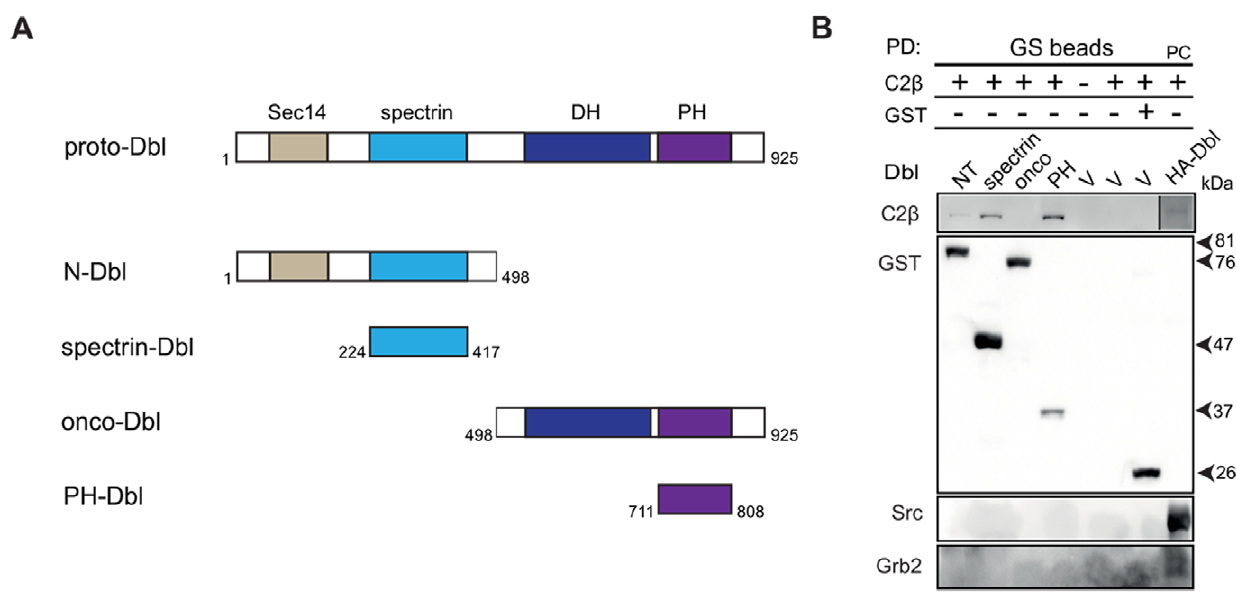
Figure 2. PI3KC2 b binds with high affinity to the spectrin- and PH- Dbl domain. (A) Schematic representation of Dbl mutant constructs, which were kind gift of Prof. Danny Manor from the School of Medicine at Case Western Reserve University, Cleveland, USA. (B) COS-1 cells co- transfected with Myc-PI3KC2 b and different GST-fused Dbl domains (N-, spectrin-, onco-, PH-) in pEBG vector were subjected to gluthatione- sepharose beads affinity-purification and immunobotted with indicated antibodies. Experiment was repeated at least two times with similar results. PC – positive control; COS-1 cells co-transfected with PI3KC2 b and HA-proto-Dbl, and immunoprecipitated with anti-Dbl antibody.